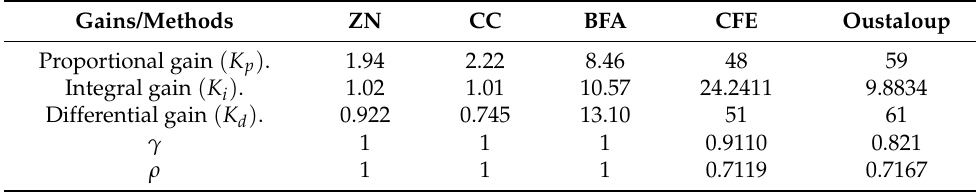
Table 4. The gains of PID and FOPID controllers for vehicle angular motion.